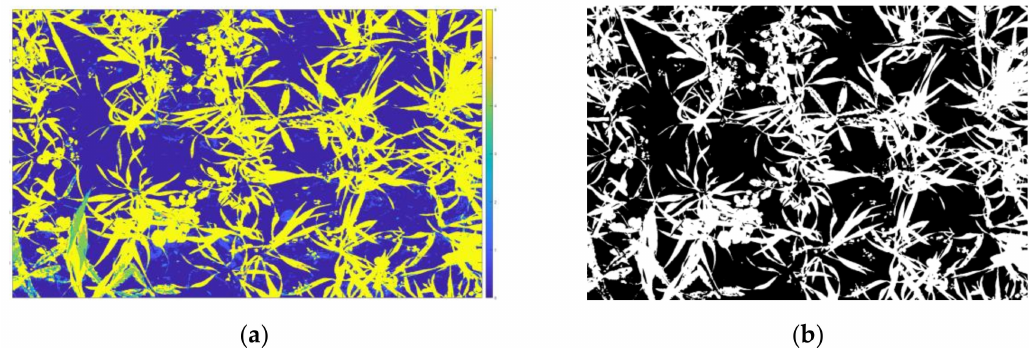
Figure 5. ( a ) Example of a MetaIndex image (Legend: blue = 0 votes and yellow = 6 votes); ( b ) Result after thresholding (white pixel for the vegetation and black for the